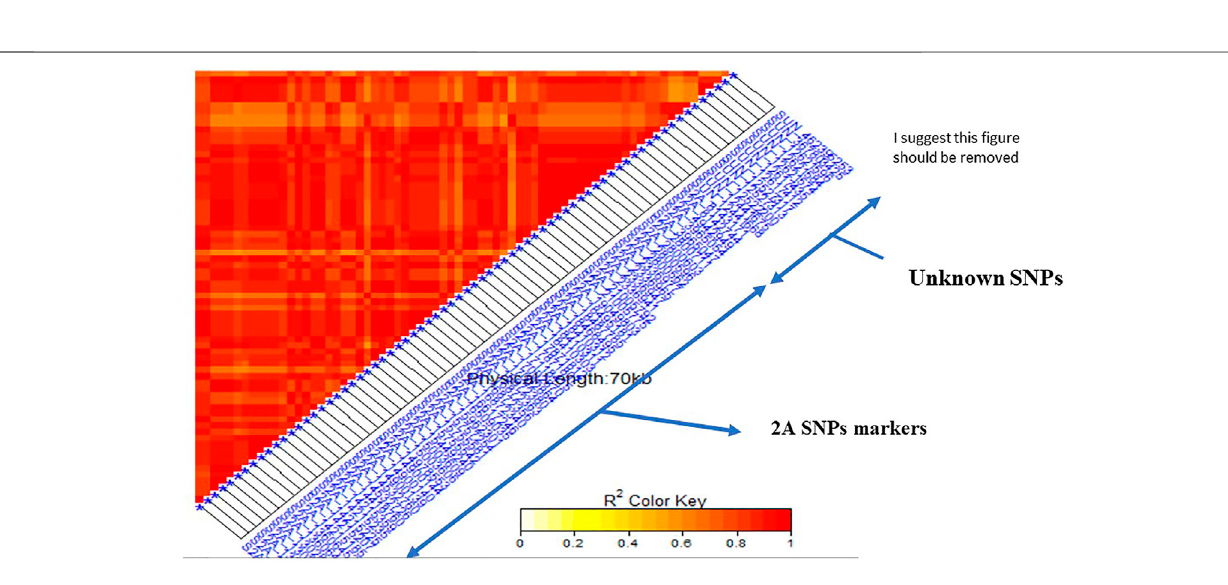
Frontiers in Genetics |